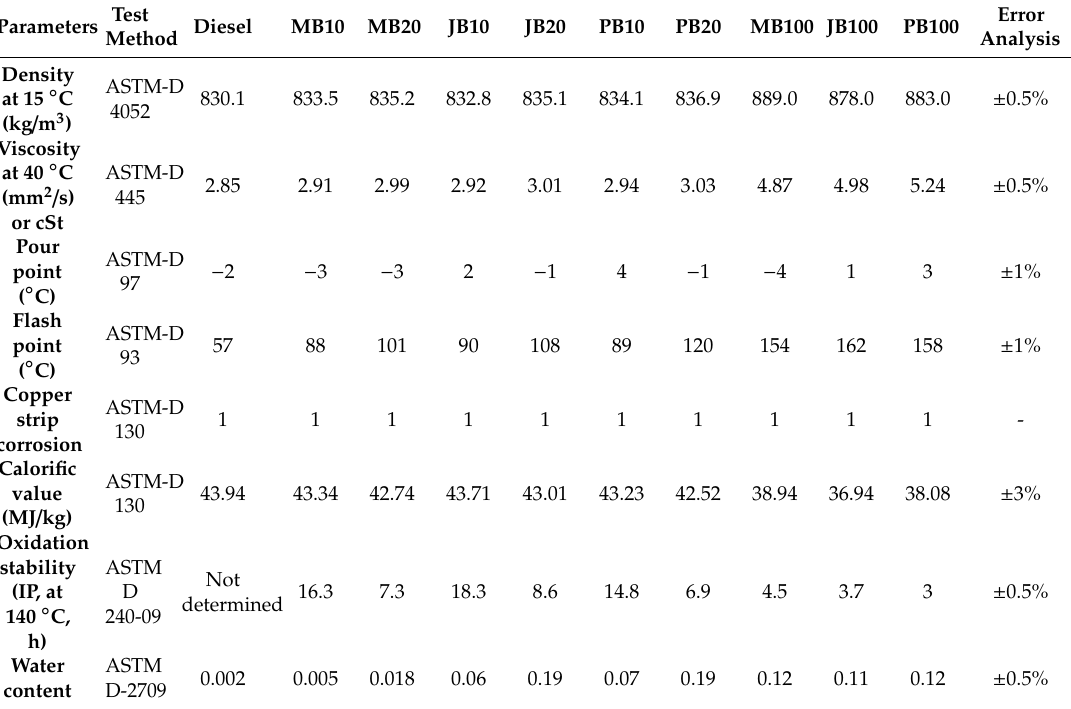
Table 2. Fuel properties of diesel and biodiesel blends.